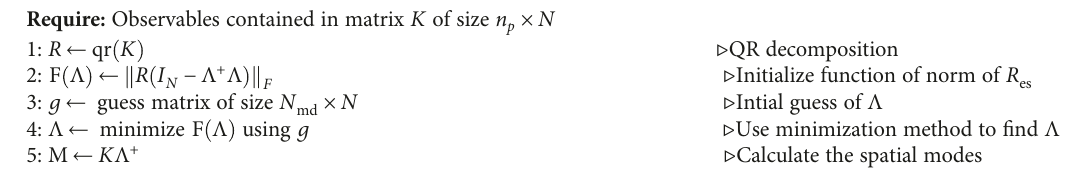
Algorithm 2: NU-DMD for uniform in time data (using QR on K